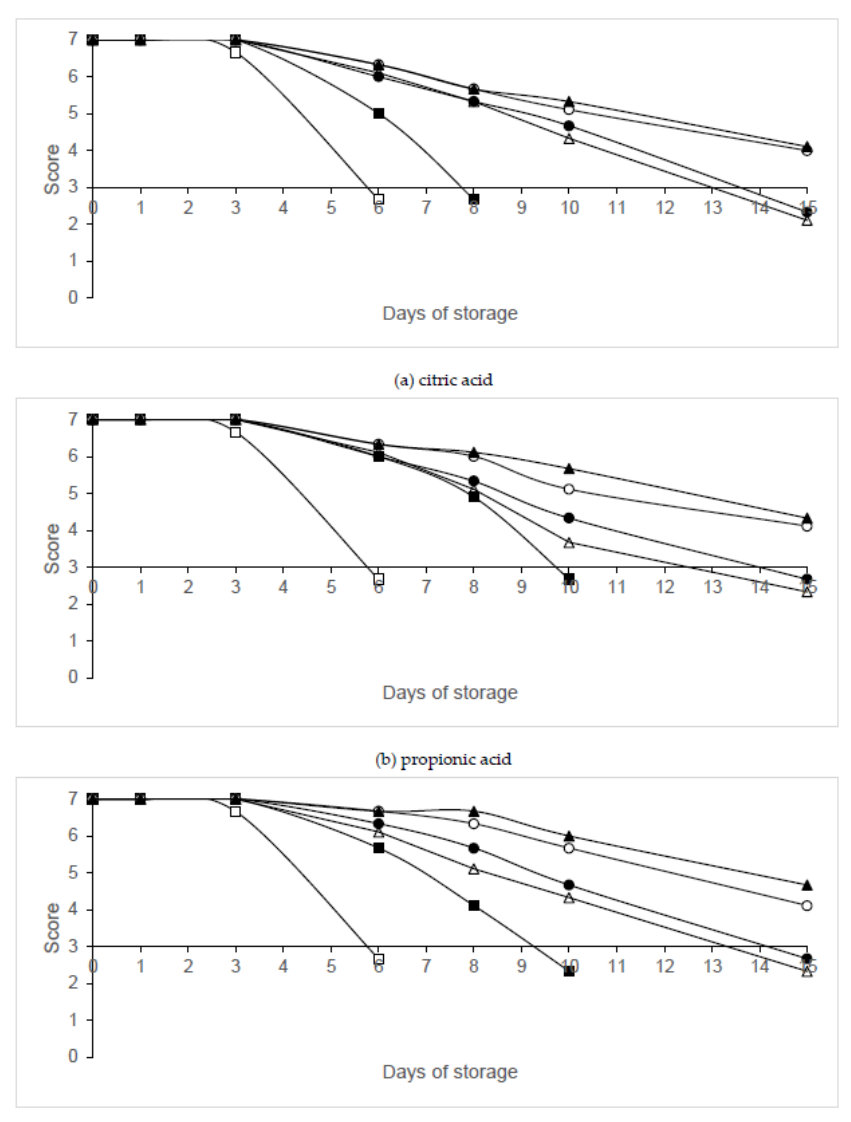
Figure 9. Evolution of sensorial scores in chicken legs treated with organic acids and packaged under modified atmospheres. Treatment conditions: Batch C, distilled water and packaging in air ( □ ); 2% organic acid, packaging in air ( ▪ ); 2% organic acid, packaging in 80% N 2 /20% CO 2 ( • ); 2% organic acid, packaging in 60% N 2 /40% CO 2 ( ◦ ); 2% organic acid, packaging in 40% N 2 /60% CO 2 ( ▲ ); 2% organic acid, packaging under vacuum ( ∆ ). ( a ) Citric acid; ( b ) propionic acid; ( c ) acetic acid. Data shown are the mean value of six determinations.